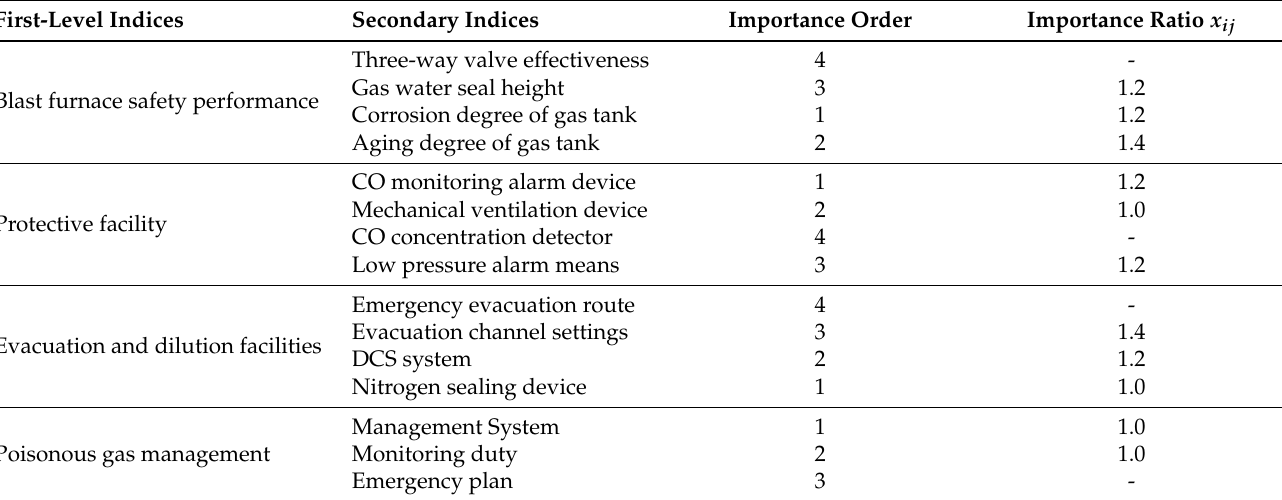
Table 3. Importance gradation of the toxic gas leak